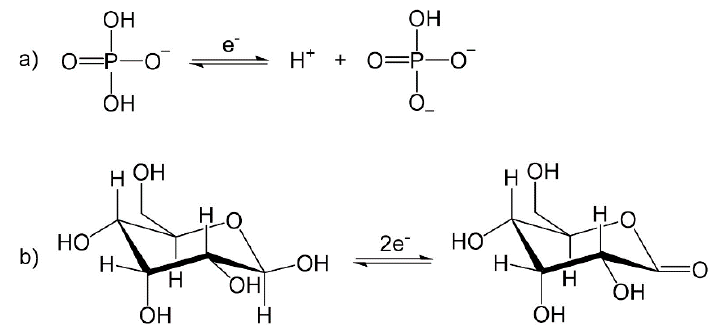
CNT-SPE electrochemically activated (CNT-SPE/A) and without activation (CNT-SPE/NA), and ( d